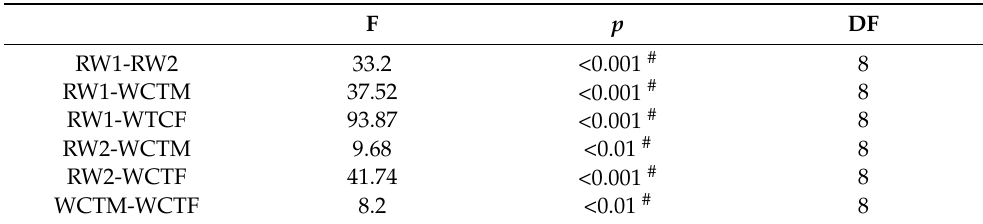
Figure 3. Linear discriminant (LD) analysis plot for individual identification of howls from Arctic wolves with a 95% correct classification. Table 5. Pairwise post-hoc Hotelling test for Arctic wolves with F-values and p -values. Symbol # indicates significant p -values after sequential Bonferroni